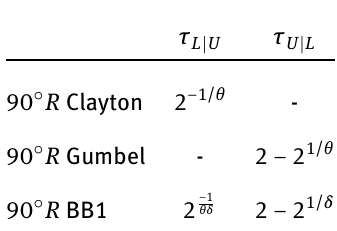
Table 12: Tail dependence for the 90 ◦ rotated copulas